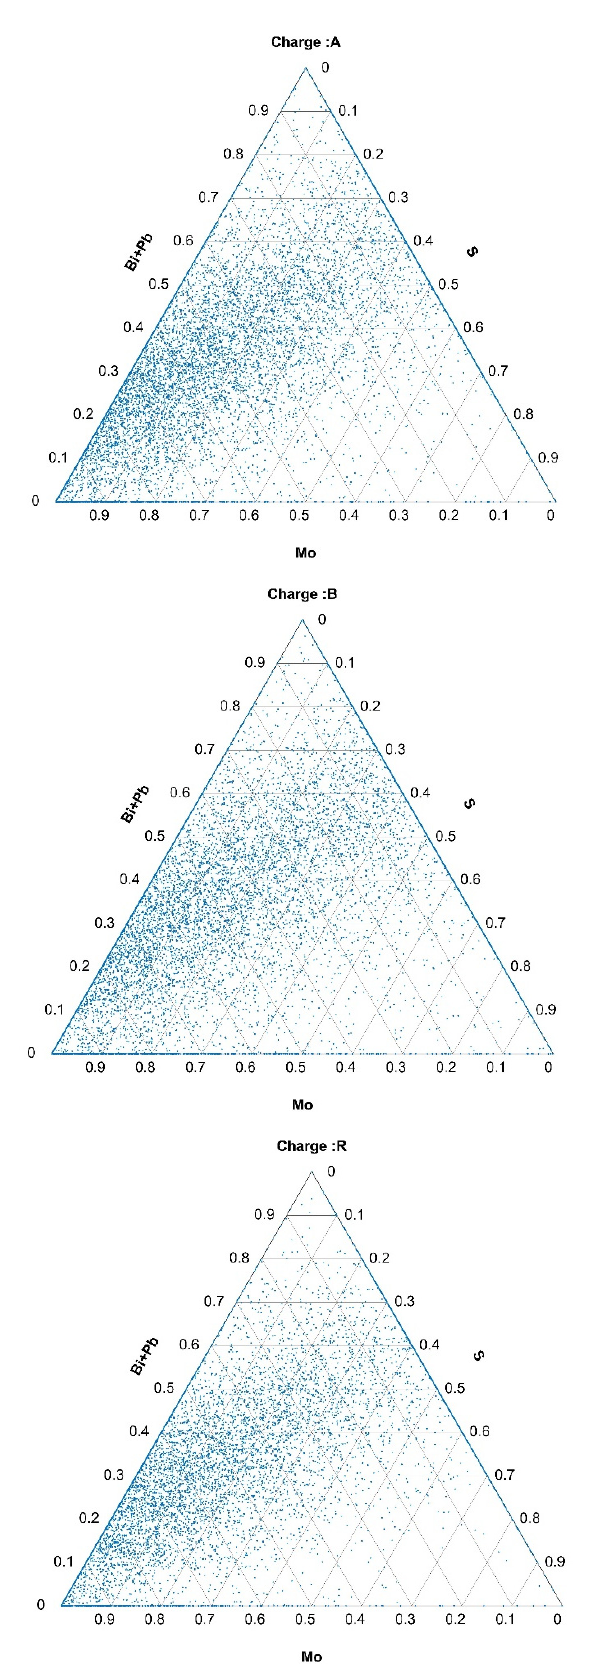
Figure 5. Composition of Mo-, S-, and Bi+Pb-containing inclusions in hot-rolled plates of Ti-stabilized Cr-Ni-Mo steel A, B, and R.